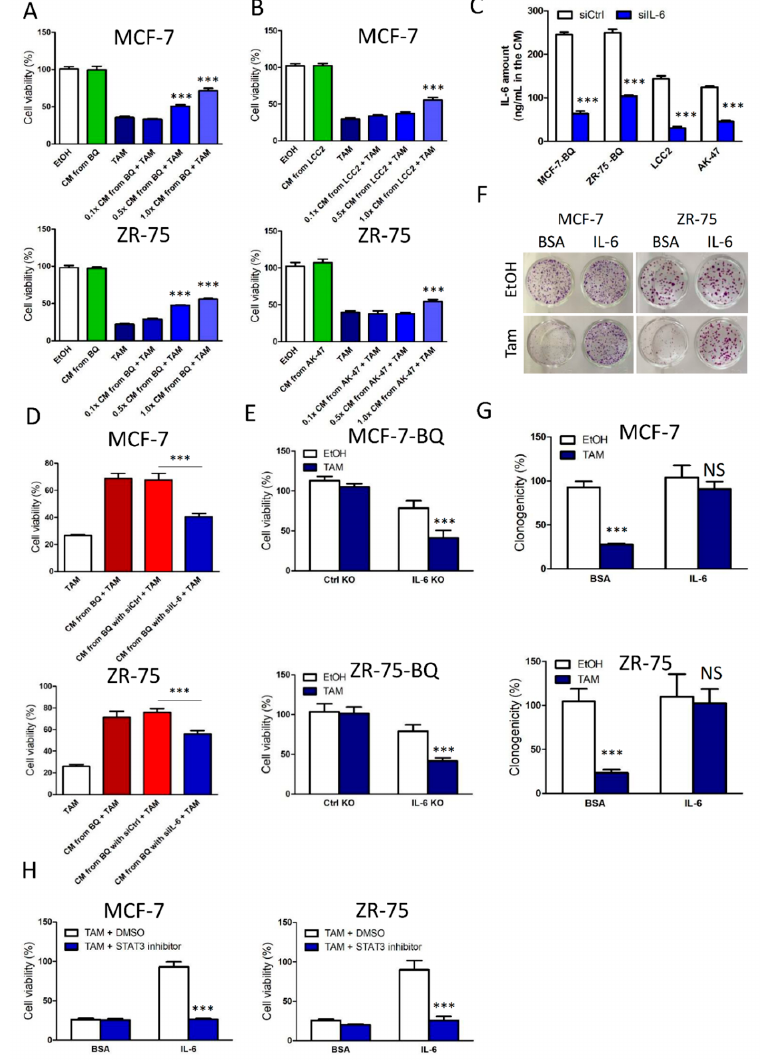
Figure 2. IL-6/STAT3 signalling pathway could modulate tamoxifen response in ER+ breast cancer cells. ( A ) Conditional medium (CM) from ectopic BQ overexpressing cells could induce tamoxifen resistance. MCF-7 and ZR-75 were cultured in CM obtained from MCF-7-BQ and ZR-75-BQ. The original CM was diluted at 0.1× and 0.5×. MCF-7 and ZR-75 cells were treated with 5 µM of tamoxifen (TAM) for 96 h. MTT assay was employed to determine cell viability. ( B ) Conditional medium (CM) from high BQ-expressing cells could induce tamoxifen resistance. MCF-7 and ZR-75 were cultured in CM obtained from LCC2 and AK-47. The original CM was diluted at 0.1× and 0.5×. MCF-7 and ZR-75 cells were treated with 5 µ M of TAM for 96 h. MTT assay was performed. ( C ) Treatment of siRNA against IL-6 could reduce the production of IL-6. The cells were treated with the siRNA against IL-6 (siIL-6) or non-targeting siRNA (siCtrl) for 72 h and ELISA was performed on the cell lysates to detect the amount of IL-6. ( D ) CM from siIL-6-treated cells lost the ability to induce tamoxifen resistance. MCF-7 and ZR-75 were cultured in CM from MCF-7-BQ and ZR-75-BQ, which were treated with siCtrl or siIL-6 for 72 h. MCF-7 and ZR-75 cells were treated with 5 µ M of TAM for 96 h. MTT assay was performed. ( E ) Knockout of IL-6 could reduce cell viability of BQ-overexpressing cells and resume tamoxifen sensitivity. IL-6 gene was stably knocked out in MCF-7-BQ and ZR-75-BQ. Plasmid-expressing non-targeting gRNA was used as the control. The cells were treated with 5 µ M of TAM for 96 h. MTT assay was performed. ( F ) IL-6 could confer tamoxifen resistance. MCF-7 and ZR-75 cells were treated with 10 ng/mL of recombinant IL-6 and 5 µ M of TAM for 2 weeks. Colony formation assay was performed to determine cell viability. ( G ) Statistical analysis of ( F ). ( H ) Inhibition of STAT3 could abolish the effect of IL-6 on tamoxifen resistance. One micrometre of STAT3 inhibitor S3I-201, 10 ng/mL of recombinant IL-6, and 5 µ M of TAM were used. MTT assay was performed after 96 h of the treatment. Results were shown as mean ± SD from at least three independent experiments. Students’ t test was used to determine the statistical significance between two groups. *** represents p < 0.001; NS represents no statistical